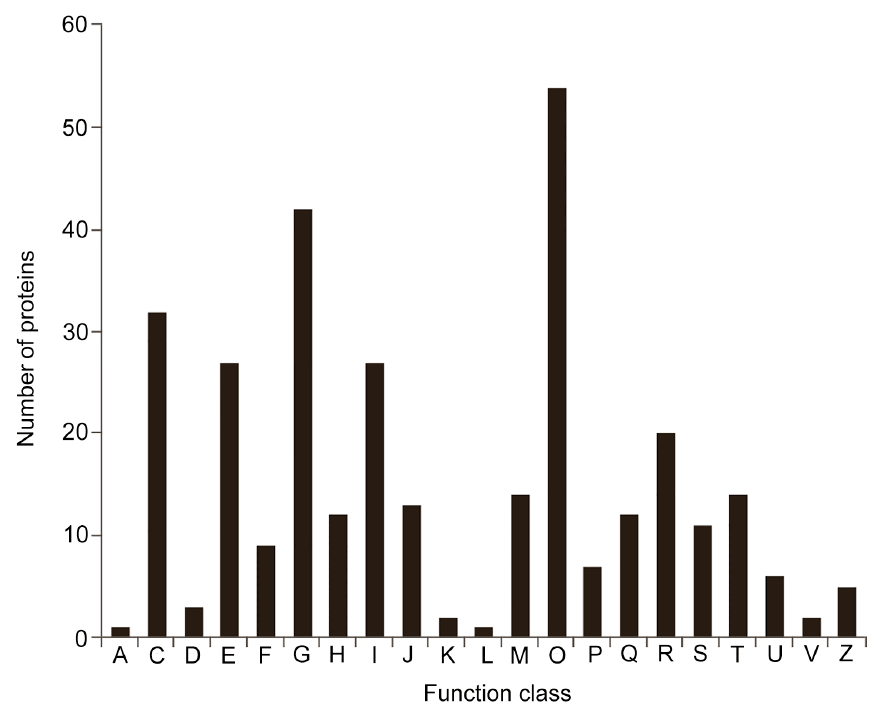
Figure 5. The Clusters of Orthologous Groups (COG) functional annotation of DEPs. A: RNA processing and modification; C: energy production and conversion; D: cell cycle control, cell division, and chromosome partitioning; E: amino acid transport and metabolism; F: nucleotide transport and metabolism; G: carbohydrate transport and metabolism; H: coenzyme transport and metabolism; I: lipid transport and metabolism; J: translation, ribosomal structure, and biogenesis; K: transcription; L: replication, recombination, and repair; M: cell wall/membrane/envelope biogenesis; O: posttranslational modification, protein turnover, and chaperones; P: inorganic ion transport and metabolism; Q: secondary metabolites biosynthesis, transport, and catabolism; R: general function prediction only; R: function unknown; T: signal transduction mechanisms; U: intracellular trafficking, secretion, and vesicular transport; V: defense mechanisms; Z: cytoskeleton. In addition to the GO-based annotation, we applied the Kyoto Encyclopedia of Genes and Genomes (KEGG) annotation for the DEPs. The analysis showed that the correspond- ing pathways could be divided into 6 primary categories (metabolism, genetic information processing, environmental information processing, cellular processes, organismal systems, and human diseases), including 19 s categories (Figure 6). The most abundant category was carbohydrate metabolism (58 DEPs). The second to fifth categories were global and overview maps (49 DEPs); amino acid metabolism (46 DEPs); energy metabolism (42 DEPs); and folding, sorting and degradation (41 DEPs), respectively. Then, KEGG